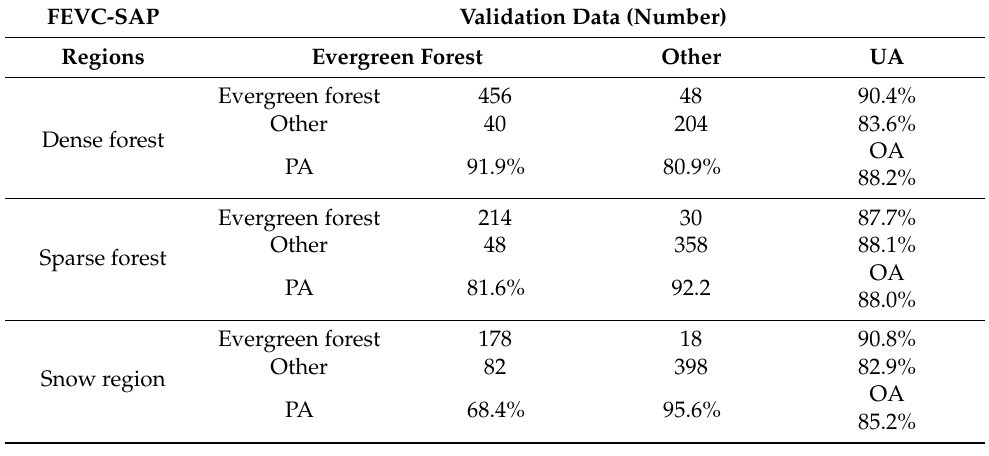
Table 4. Comparison of extraction accuracy values among three regions based on FEVC-SAP model.